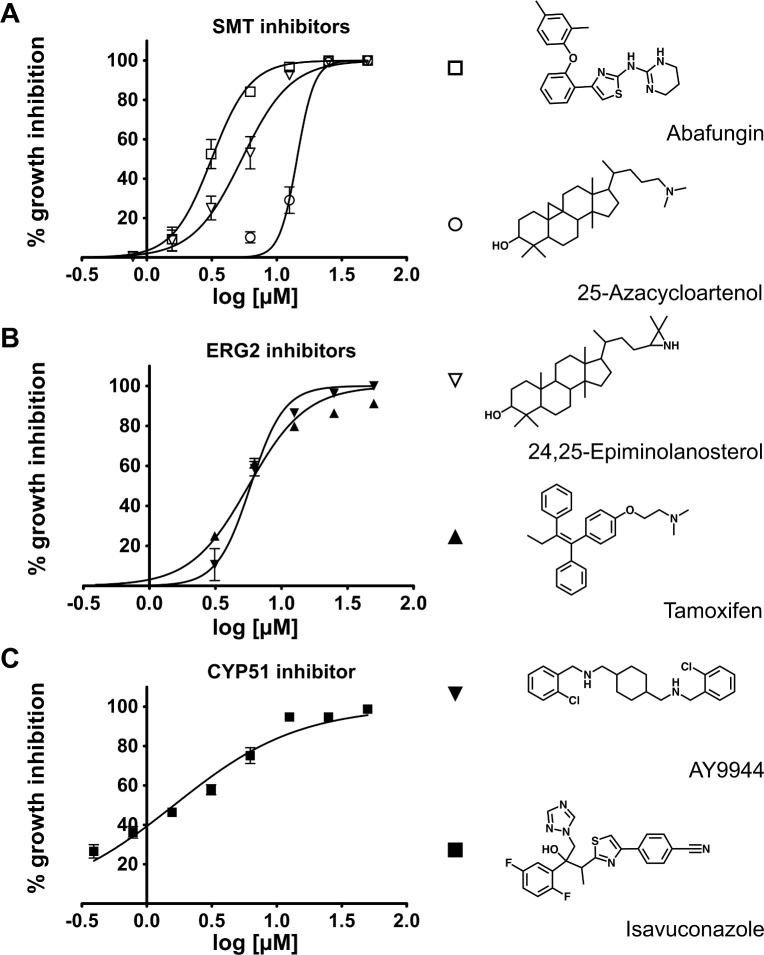
Dose-response growth inhibition of N. fowleri trophosoites.Dose-response curves are shown for (A) SMT inhibitors: abafungin, 25-azacycloartenol and 24,25-epiminolanosterol, (B) ERG2 inhibitors: tamoxifen and AY9944, (C) CYP51 inhibitor isavuconazole.